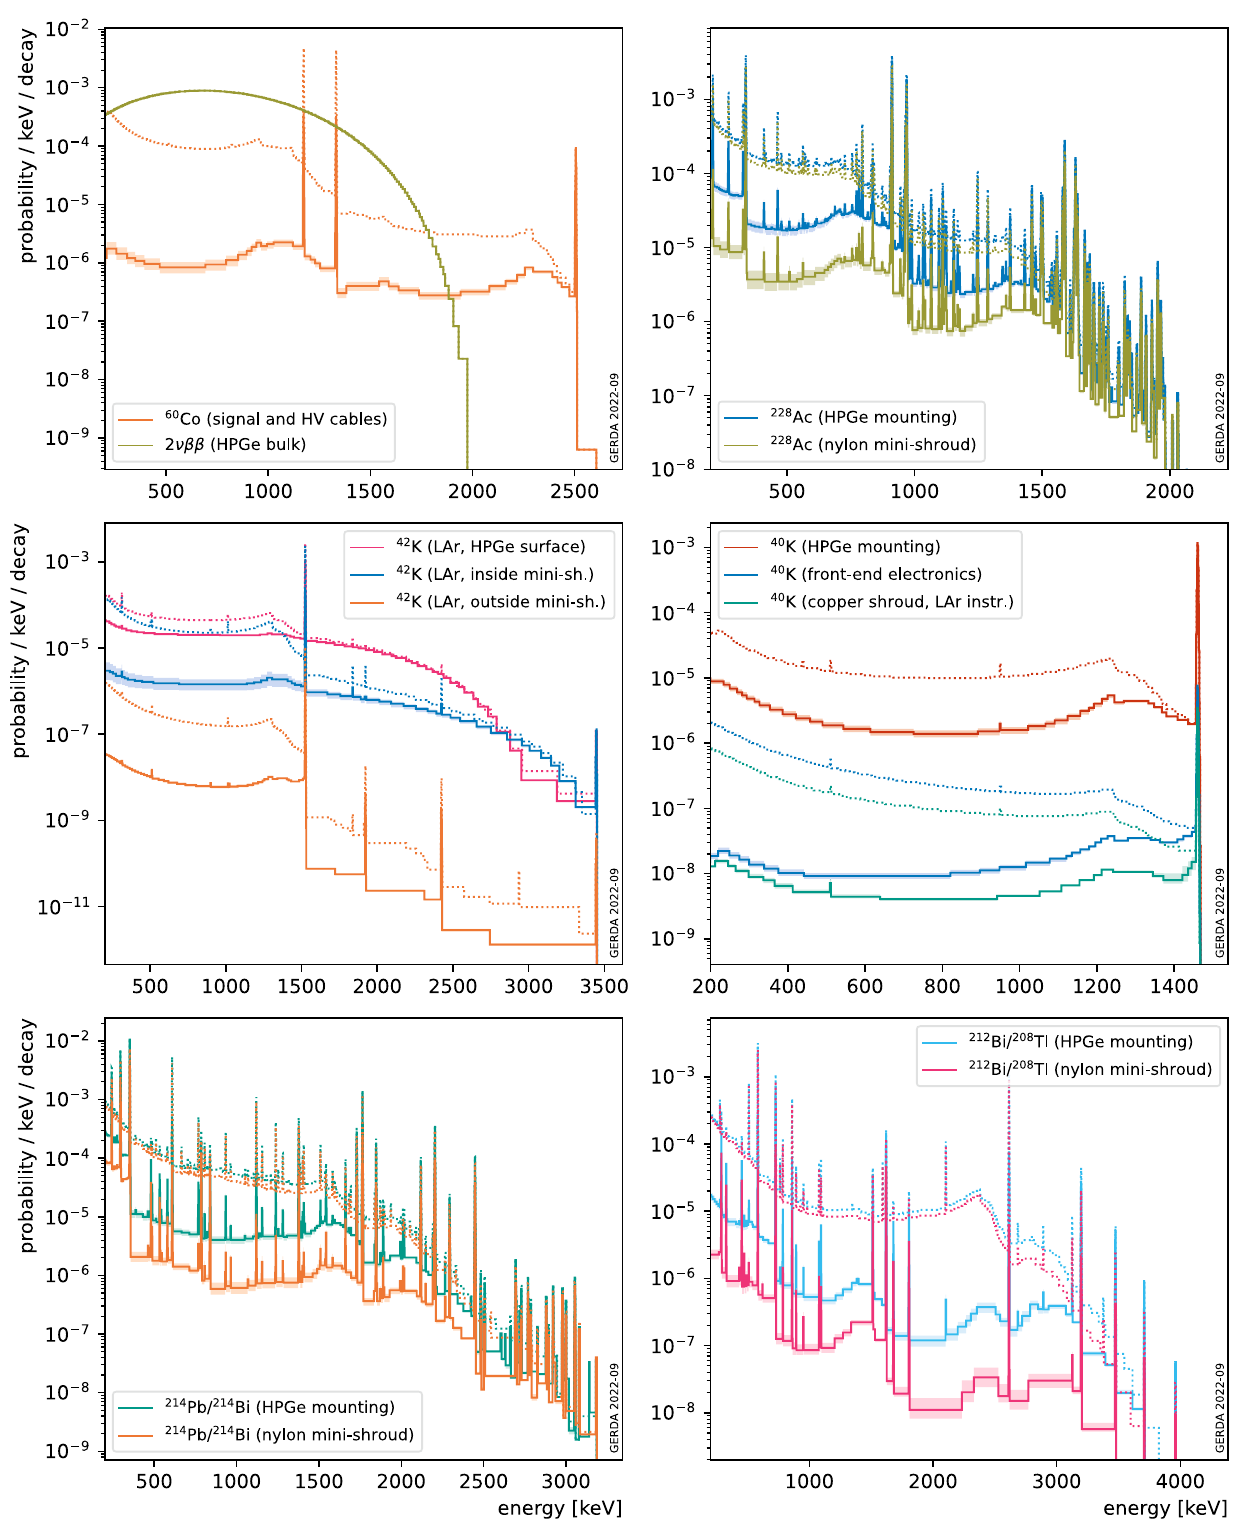
Fig. 7 Probabilitydensityfunctions( pdfs ,normalizedtothenumberof simulated primary decays) for a representative selection of background and signal event sources in the Gerda PhaseIIsetup as detected by HPGe detectors and surviving the LAr veto cut, as predicted by the model presented in this document. Model uncertainties are shown as